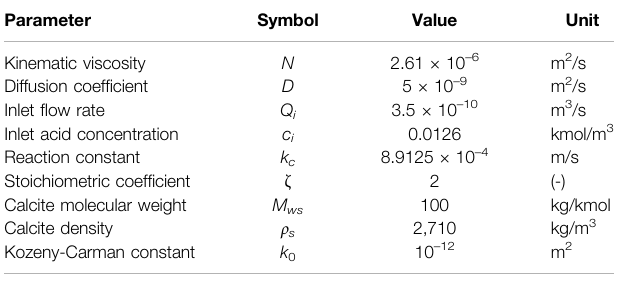
TABLE 1 | Simulation parameters for Benchmark 1.